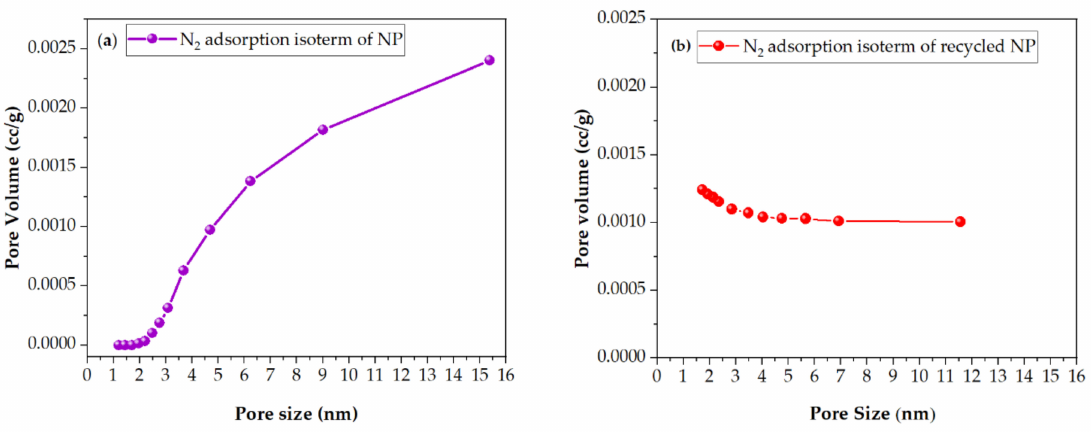
Figure 5. Pore size distributions curve (BJH) of: ( a ) NP, and ( b ) 6-recycled NP. Table 2. Surface area, pore volume and average pore size of NP and 6-recycled NP.